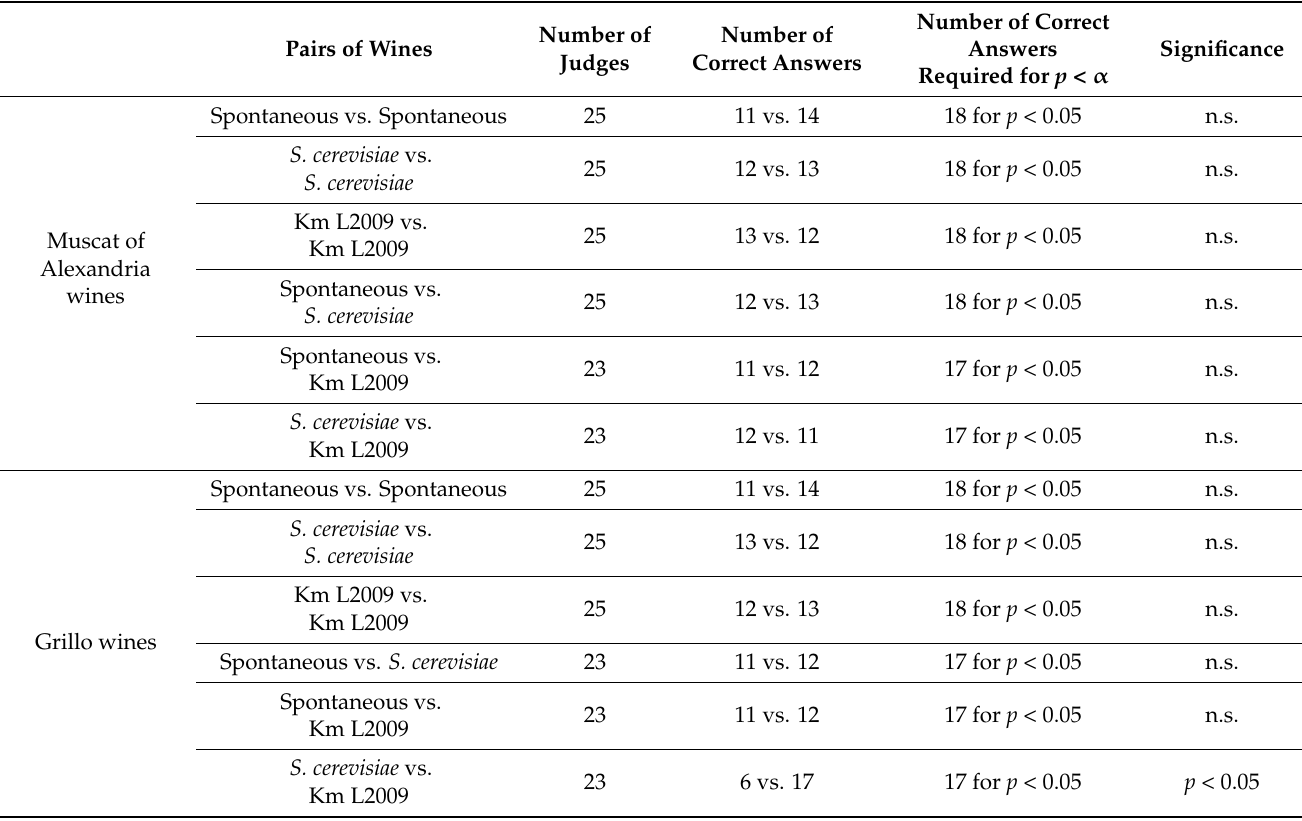
Table 7. Results of the paired comparison test performed with Muscat of Alexandria (top) and Grillo (bottom) wines produced by spontaneous fermentation (Spontaneous), by the Saccharomyces cerevisiae commercial strain QA23 ( S. cerevisiae ) and by Kluyveromyces marxianus Km L2009 strain (Km L2009). p : p -value; α : significance level; n.s.: not significant. Number of Correct Number of Number of Answers Significance Pairs of Wines Judges Correct Answers Required for p < α